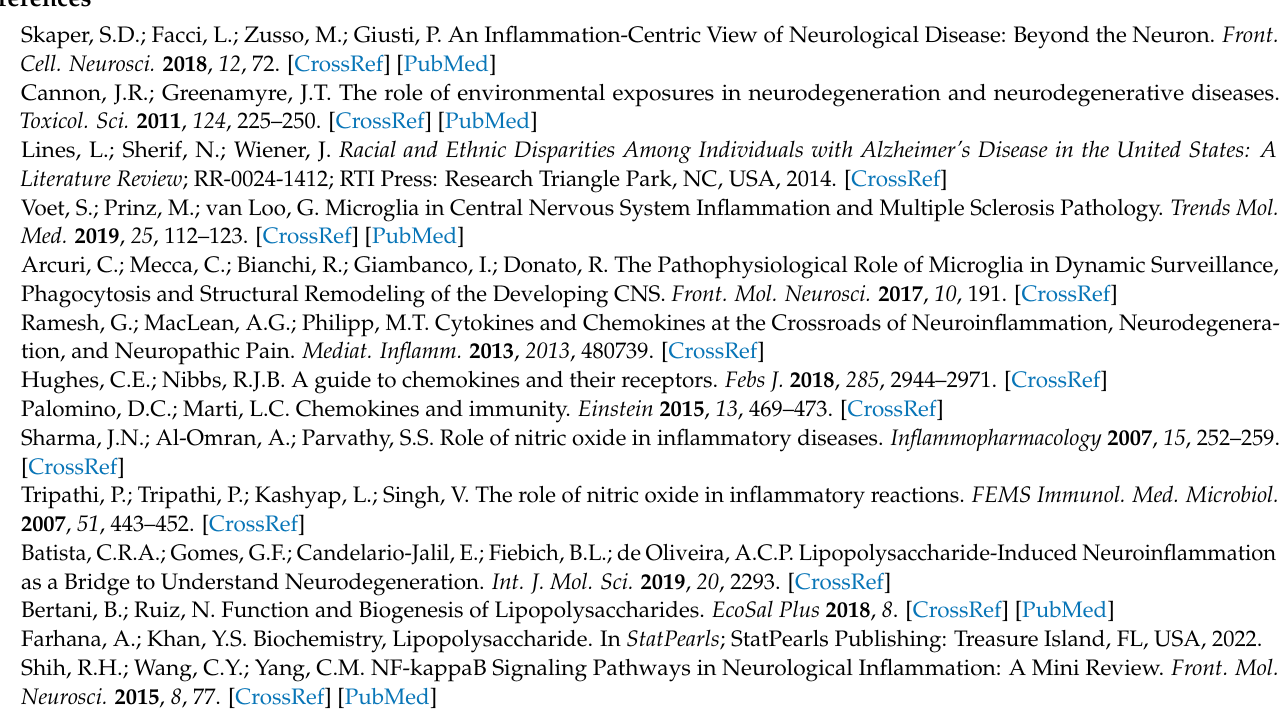
Figure S3: mTOR protein expression normalizing with α -Actinin; Table S1: PCR array analysis of cytokines/chemokines correlated to neuroinflammation and oxidative stress; Table S2: PCR array evaluation of signaling pathways linked to neuroinflammation and oxidative